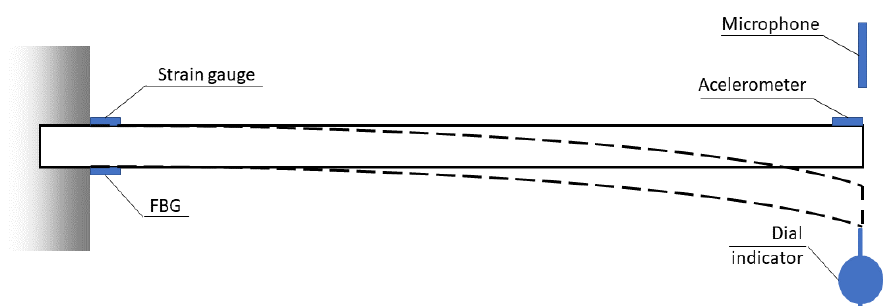
Figure 3. Cantilevered mortar beam and